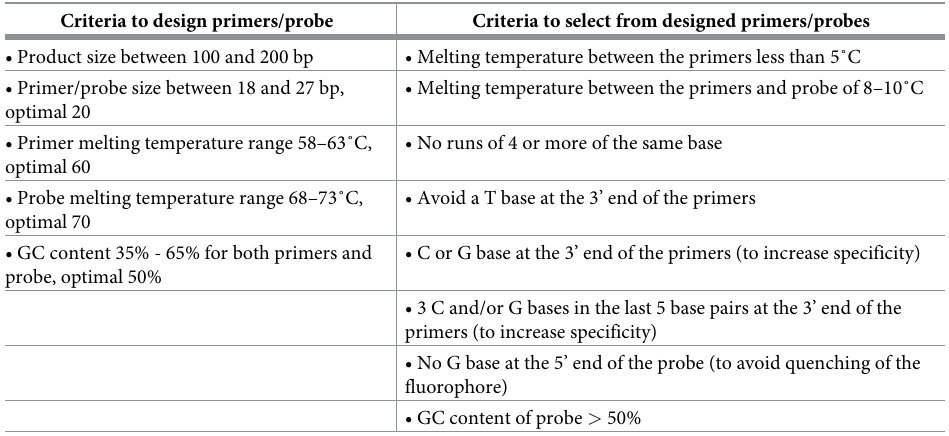
Table 1. Criteria used for designing primer/probe sets and criteria used to assess primer/probe sets in silico . Criteria to design